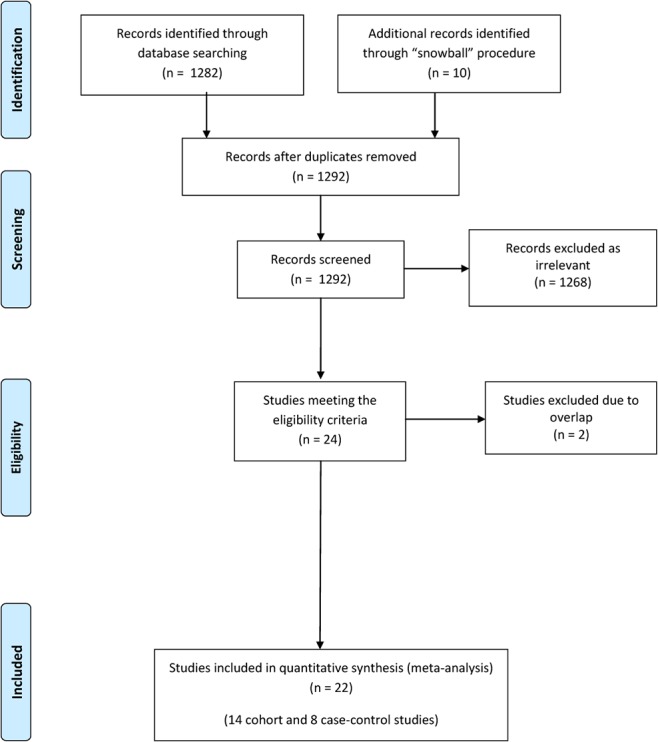
Flow chart describing the successive steps during the selection of eligible studies.